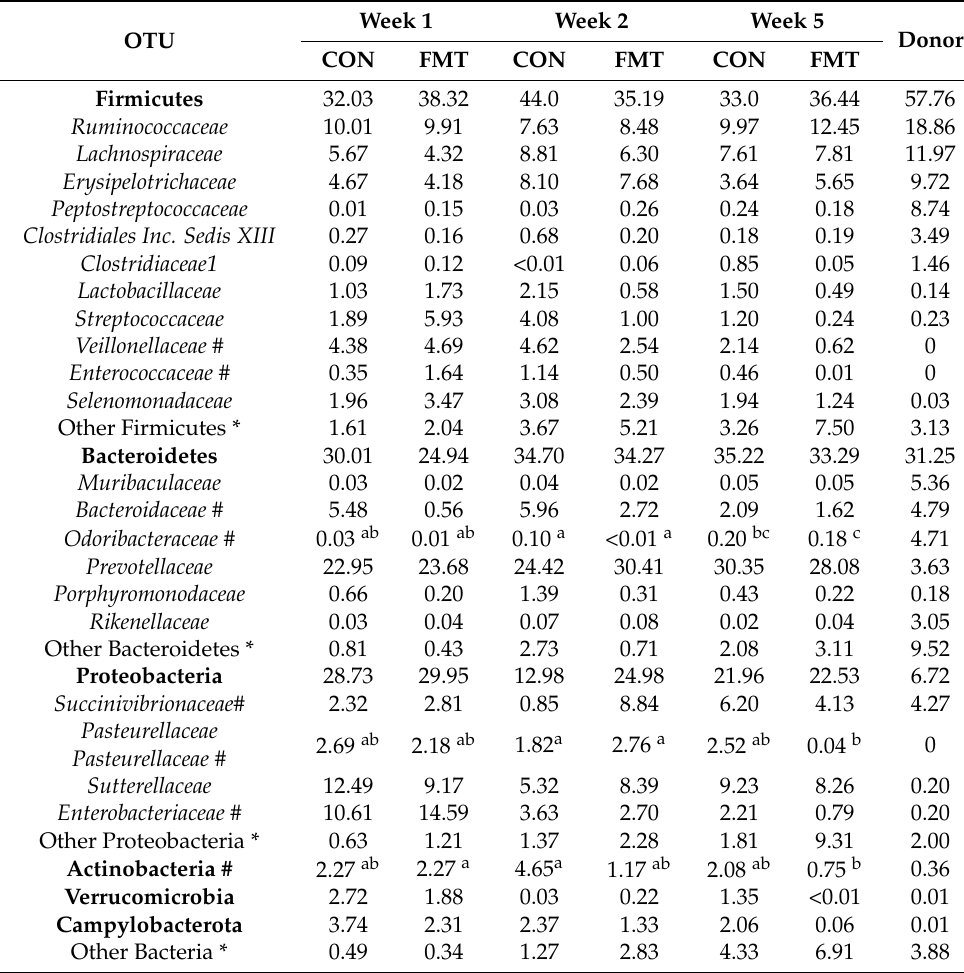
Table 2. Mean relative abundance (%) of the main bacterial groups identified in the fecal samples of control (CON) and fecal microbiota transplantation (FMT) calves, and the donor cow analyzed in this